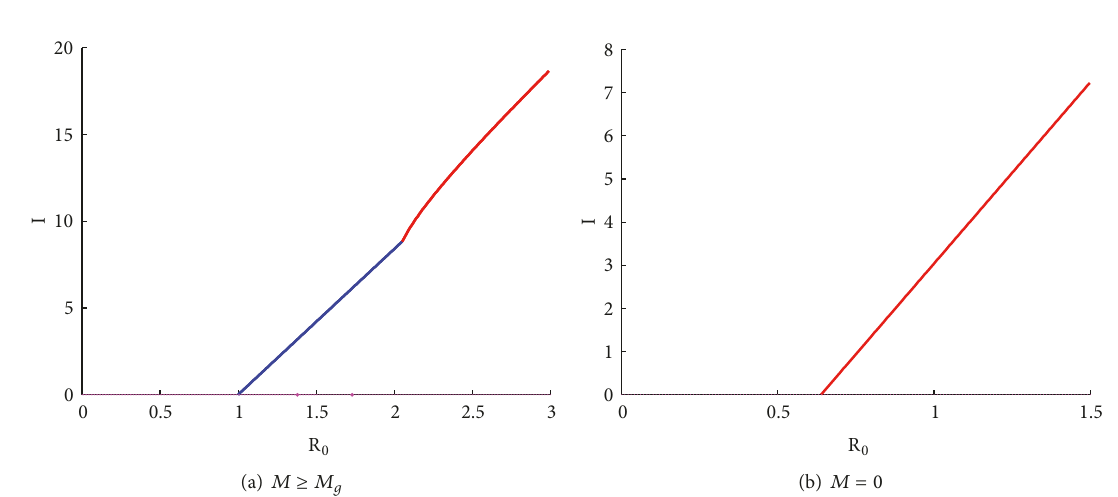
Figure 3: The relationship between the basic reproduction number and infected dairy cows while 𝑀 ≥ 𝑀 𝑔 and 𝑀 = 0 , where (2) and (3) of Theorem 9 holds. The common values of (a) and (b) used for the parameters are as follows: 𝑤 = 3 , 𝑑 = 2 , 𝑐 = 0.8 , 𝛿 = 4 , 𝑞 = 1 , 𝛽 = 0.2 , 𝑎 = 2 , and 𝑚 = 0.1 . The different values of (a) and (b) are (a) 𝑀 = 0.5 , (b) 𝑀 = 0 . There is a forward bifurcation at 𝑅 0 = 1 in (a). The bifurcation at 𝑅 = 0.6383 in (b) is still 0